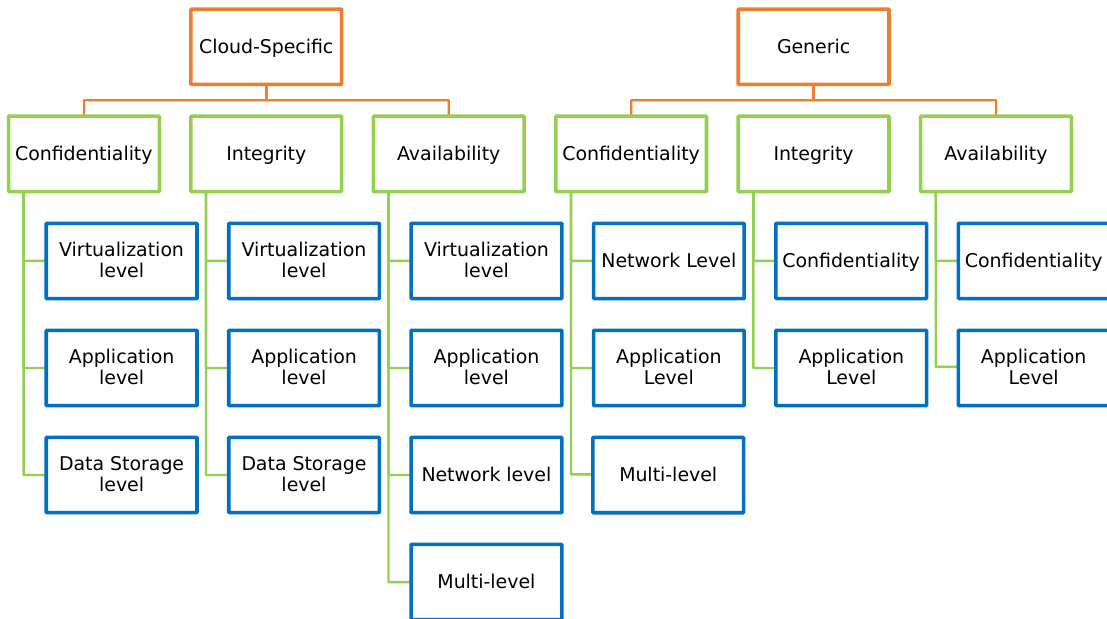
Figure 5. Classification of Cloud security